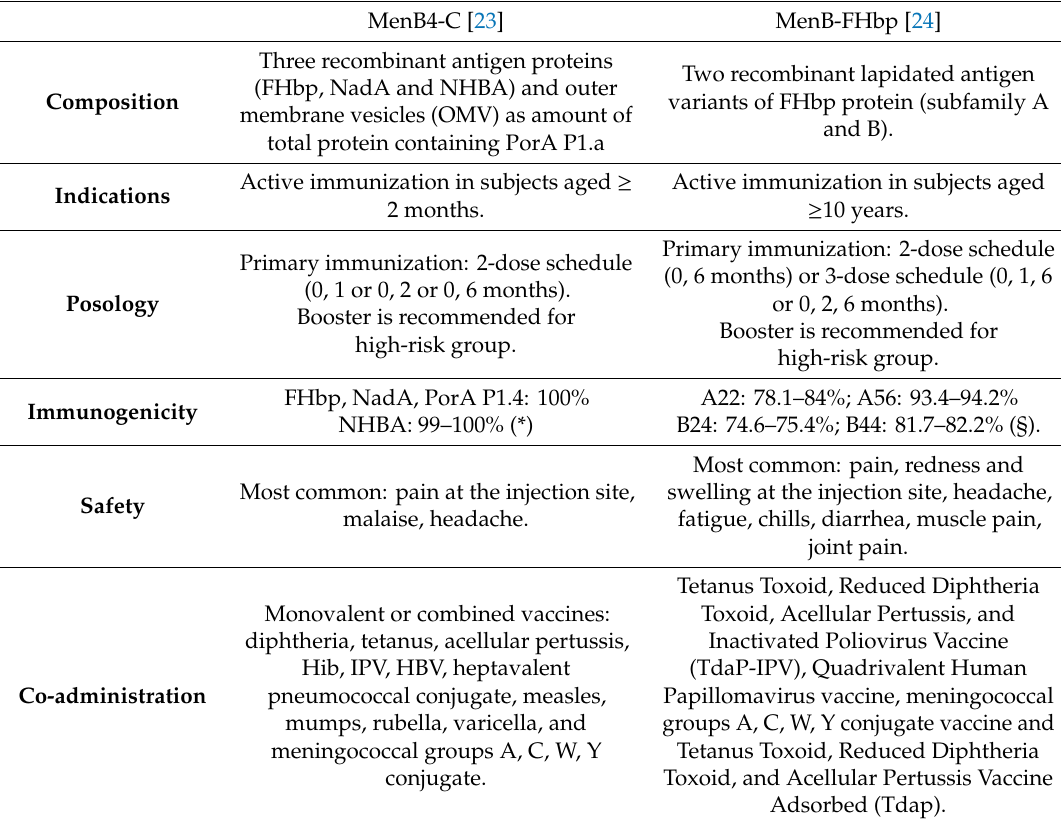
Table 3. Summary of the characteristic of the anti-meningococcus B vaccines licensed in Italy, referring to the adolescent population. NOTE: *:% seropositivity (% of subjects who achieved an hSBA ≥ 1:4) one month after the last dose. hSBA: serum bactericidal activity with human complement. §:% of subjects who achieved a ≥ 4-Fold rise in hSBA titre one month after the last